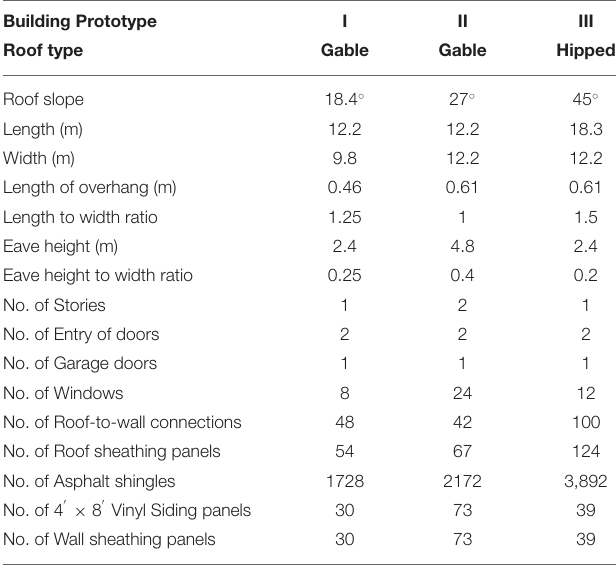
TABLE 1 | Metadata on Building Components within the Prototype Houses of the ETDA Tool. Building